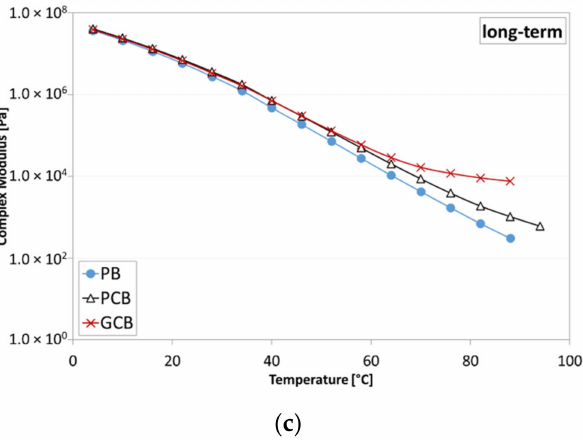
Figure 12. Isochrones of the complex modulus at 0.159 Hz: ( a ) unaged condition; ( b ) short-term aged condition; ( c ) long-term aged condition.